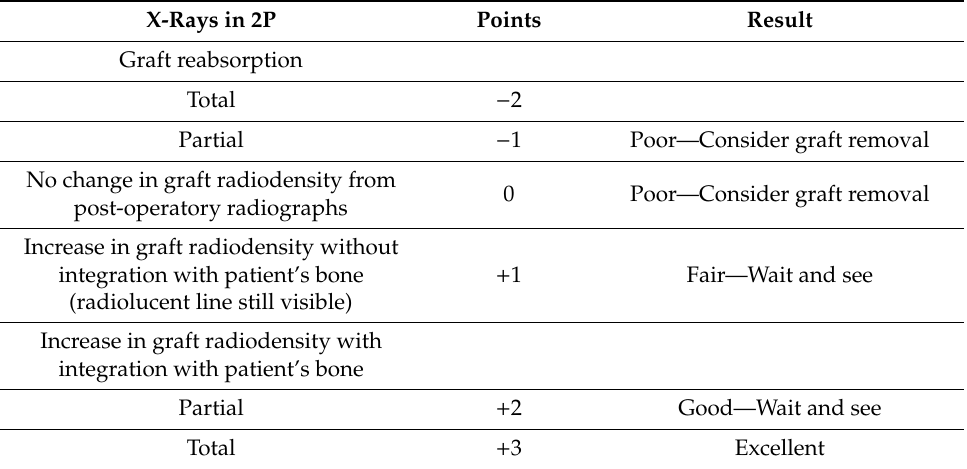
Table 3. Radiological follow-up form to value autografts and allografts, proposed by Mosetto [23]. X-Rays in 2P Points Result